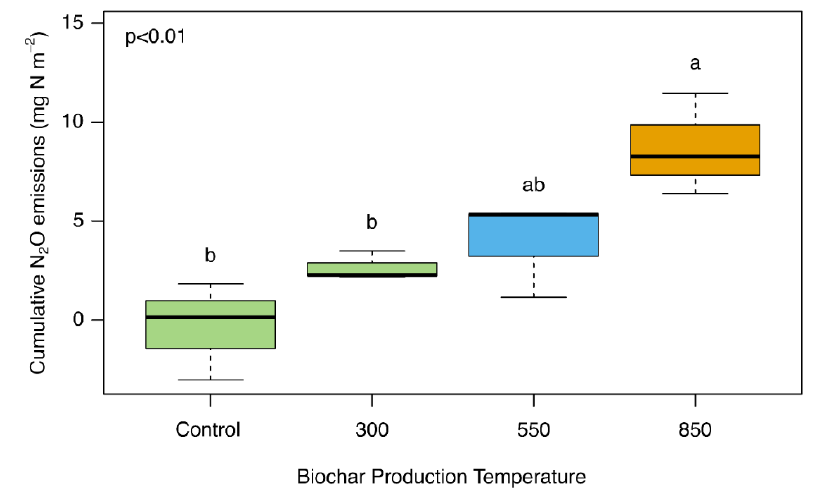
Figure 3. Total cumulative N 2 O fluxes (mg N m − 2 ) for the di ff erent production temperatures of biochar